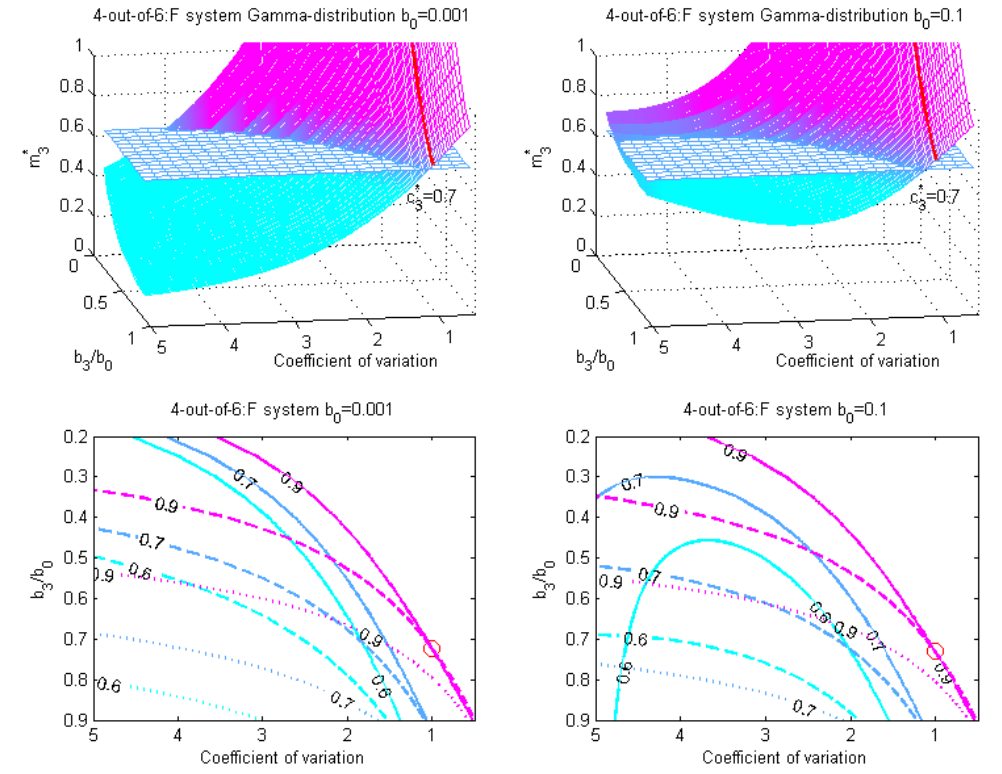
Figure 3. The surfaces m ∗ for b 0 = 0.001 and b 0 = 0.1 versus coefficient of variation v and fraction b 3 3 b 0 (upper graphs) and level curves of the surface m ∗ (lower graphs) for the 4-out-of-6 : F –system. 3 The upper graphs show the surfaces m ∗ for the Gamma distribution of the system 3 unit lifetime for the values b 0 = 0.001 (left) and b 0 = 0.1 (right) and their intersection = 0.7. The red line on the with the plane corresponding to the value of the indicator c ∗ 3 surfaces corresponds to an exponential distribution, at which the surface turns into a